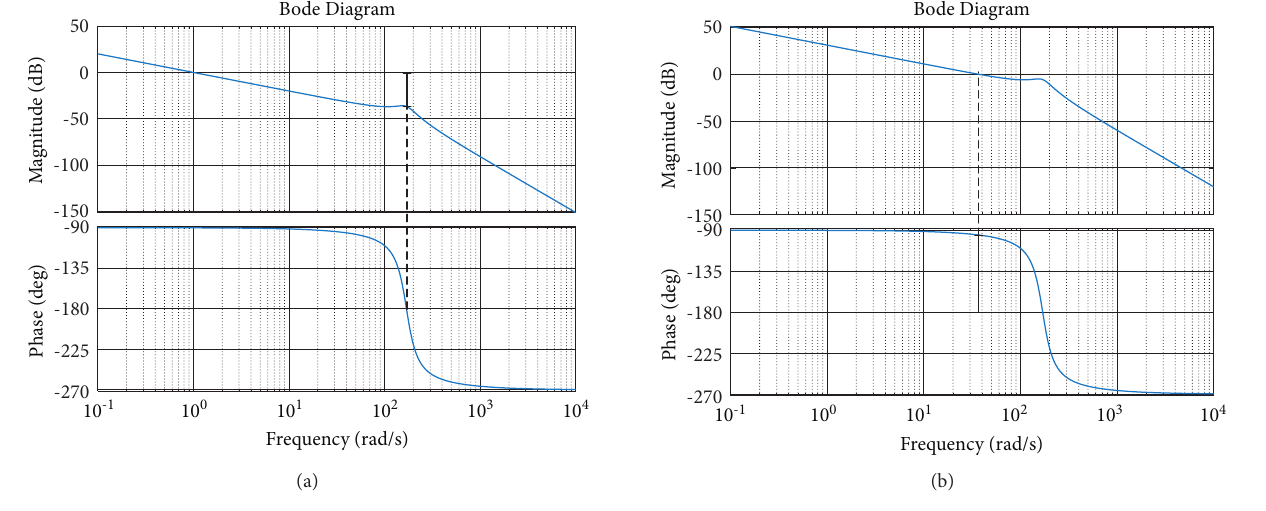
Figure 12: The open-loop Bode plot of the system. (a) K